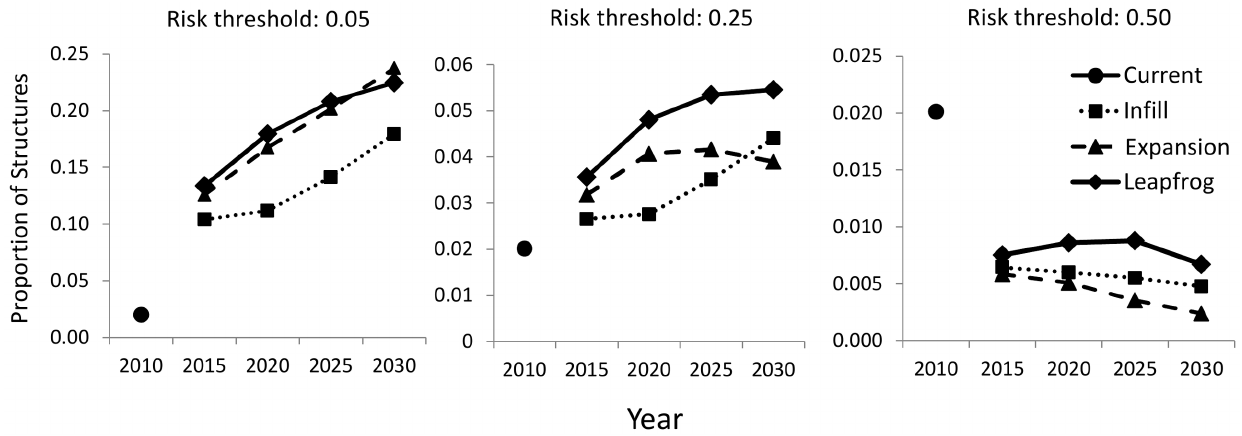
Figure 6. Proportion of residential structures that are located in areas of high fire risk defined using thresholds from the fire risk model of 0.05, 0.25, and 0.5 for current structures and for structures simulated under infill, expansion, and leapfrog growth policies.